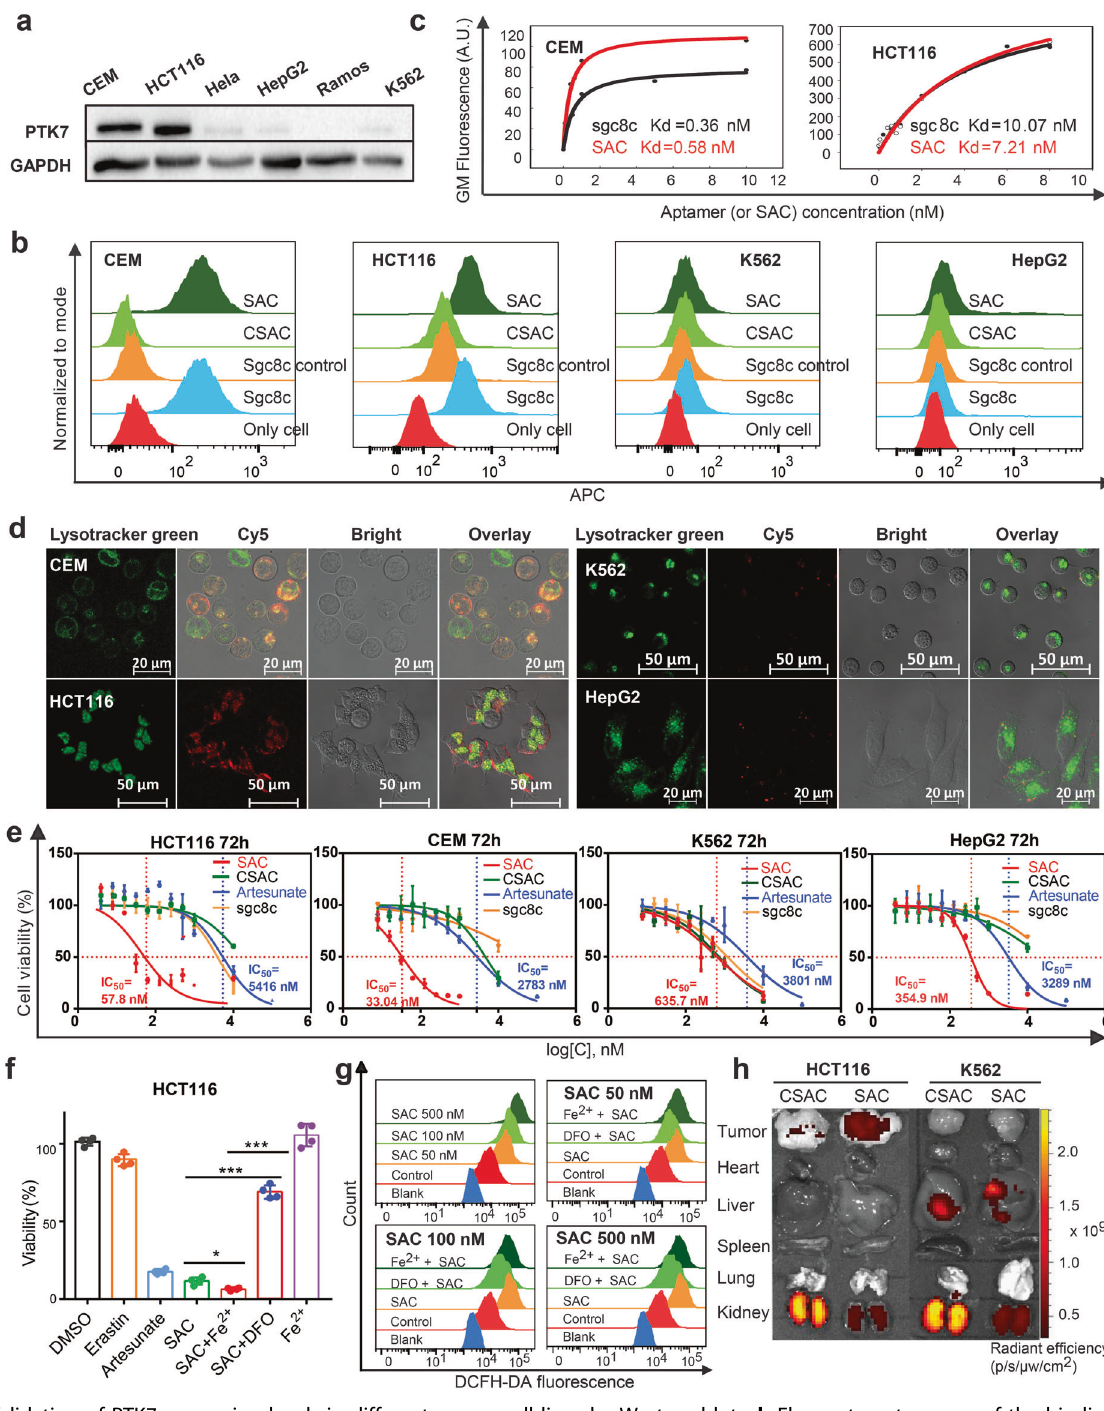
Fig. 1 a Validation of PTK7 expression levels in different cancer cell lines by Western blots. b Flow cytometry assay of the binding of SAC, CSAC, sgc8c control and sgc8c (250 nM, Cy5-labeled sequences). c Flow cytometry analysis of binding af fi nity of SAC to PTK7-positive cell lines, CEM and HCT116. d Confocal microscopy shows that SAC (250 nM, Cy5-labeled) could selectively internalize into PTK7- positive CEM and HCT116 cells after 2 h incubation at 37 °C. e Cell viability analysis by CCK8 assay (SAC, the red curves; artesunate, the blue curves). f The activation of SAC is related to Fe 2 + . The addition of exogenous FeSO 4 (10 μ M) and iron chelator DFO (10 μ M) were incubated with HCT116 cells for 2 h and then they were removed and SAC (10 μ M) was added and incubated with HCT116 for 48 h. 10 μ M DMSO, erastin and artesunate were added as control groups. *** P < 0.001, * P < 0.02; n = 4. g Measurement of the generation of reactive oxygen species (ROS) triggered by SAC (50, 100, 500 nM respectively): Cellular ROS levels were measured by dichloro fl uorescein diacetate (DCFH-DA) (200 μ M Fe 2 + , 200 μ M DFO respectively, 5 μ M DCFH-DA) after 24 h incubation with SAC. h The distribution of Cy5-labeled SAC (50 μ M, 100 μ L) and CSAC (50 μ M, 100 μ L) in tumor and major organs of HCT116 and K562 tumor-bearing nude mice after intravenous injection at 6 h visualized by Lumina XR in vivo imaging system